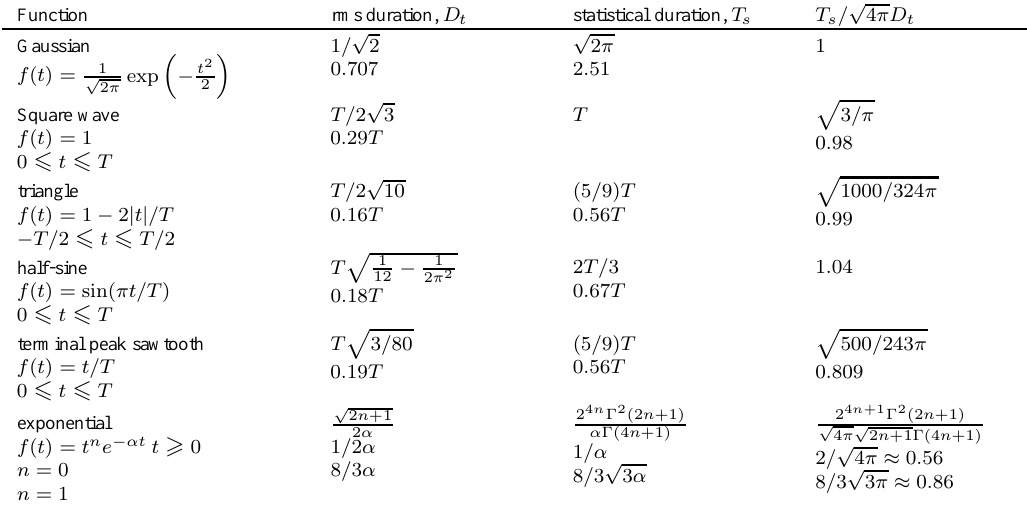
Table 1 Rms duration and statistical duration for several